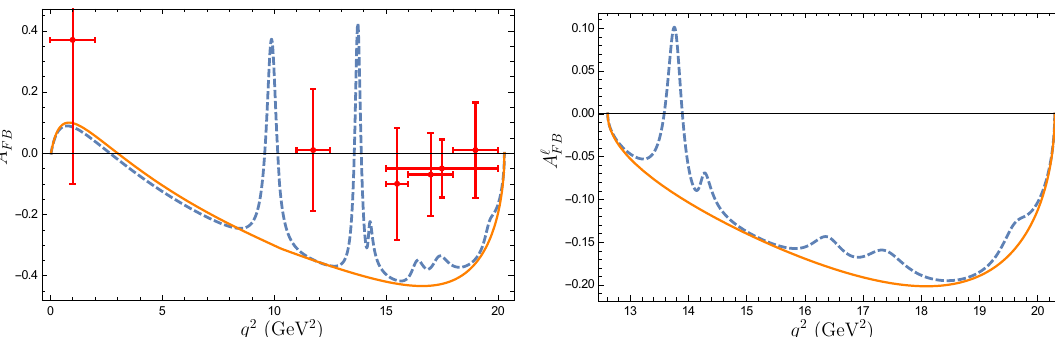
Λ µ + µ ( q 2 ) in the Λ b − FB →